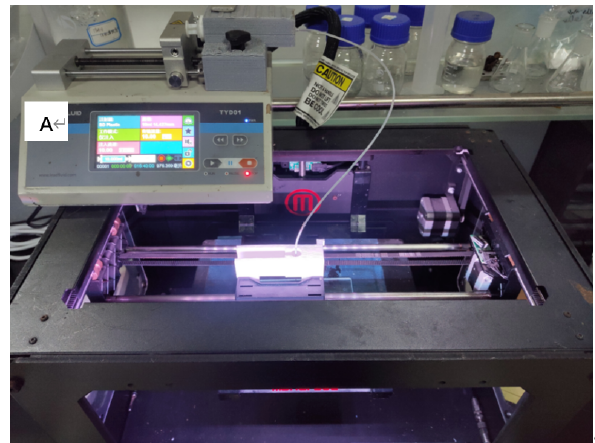
Figure 1: The viscous solution extrusion 3D printer for printing cellulose hydrogel scaffolds. A is the controllable pump fixed with a syringe and needle to pipe out the cellulose solution by